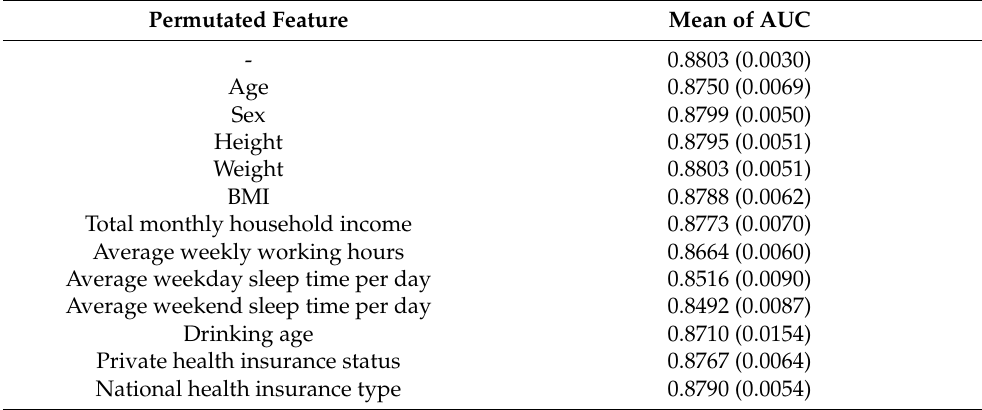
Table 8. Sensitivity analysis results of hepatitis B risk association model. Standard deviation is presented in